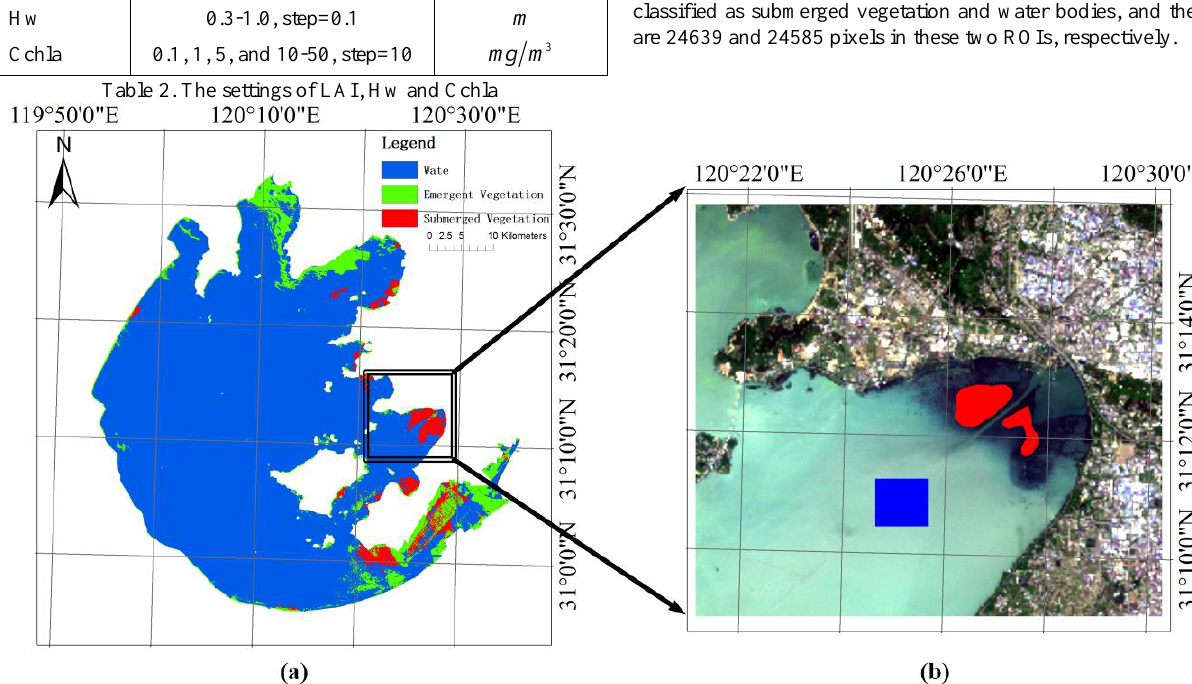
Figure 2. The remote sensing data used in the analysis. (a) The classification data set of aquatic vegetation in Taihu Lake, where the blue, green and red regions are classified as water, emergent vegetation and submerged vegetation, respectively. (b) The eastern part of Taihu Lake in the satellite image of Sentinel-2A, where the red and blue regions are classified as submerged vegetation and water bodies,